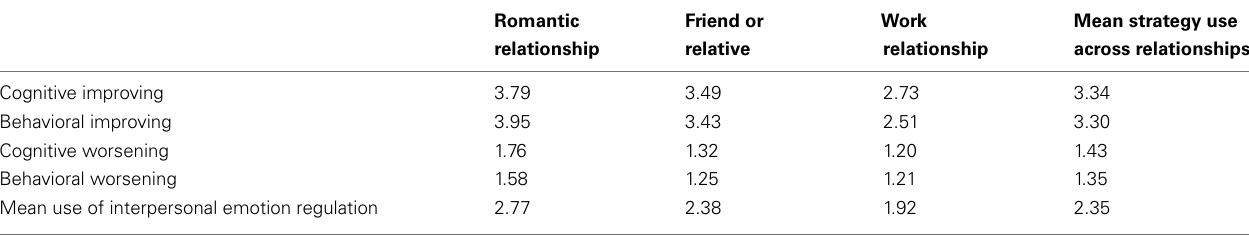
Table 2 | Mean use of interpersonal emotion regulation strategies in different